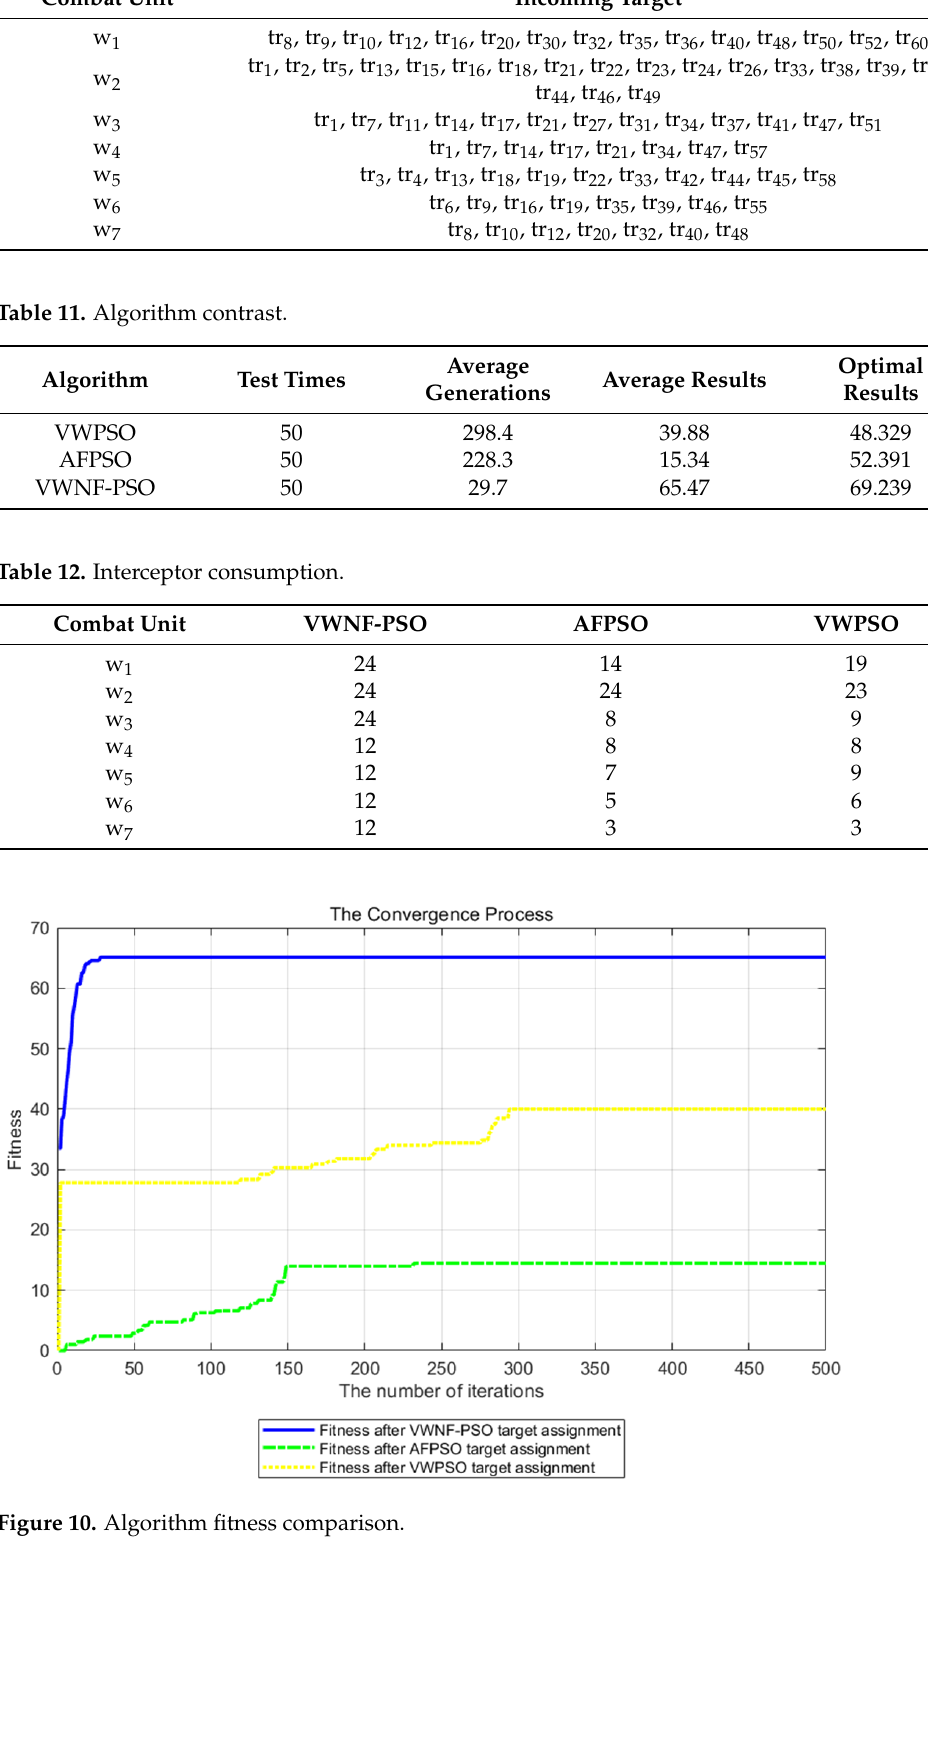
Figure 11. Number of interceptors consumed. 4.3. Data Analysis From the perspective of algorithm performance. Under the condition of small ‐ scale experimental, the VWPSO algorithm and the AFPSO algorithm have a small gap with the VWNF ‐ PSO algorithm in the calculation of fitness, the output plans of VWPSO, and AFPSO can also be used as a feasible solution for target assignment in practical applica ‐ tion. However, the abilities of the VWPSO and the AFPSO to jump out of local optimum are poor, and they can easily fall into local optimum. In addition, they need more algebra to converge. When scaled up to the limits of the combat units’ interception capabilities, the disadvantages of the VWPSO algorithm and AFPSO algorithm tendency to fall into local optimal are more obvious. There is a big gap between the obtained scheme and the actual optimal solution, and the plan is no longer usable as a viable solution. VWNF ‐ PSO algorithm has better global search ability and faster search speed, which can adapt well to the requirements of solving the model proposed in this paper.